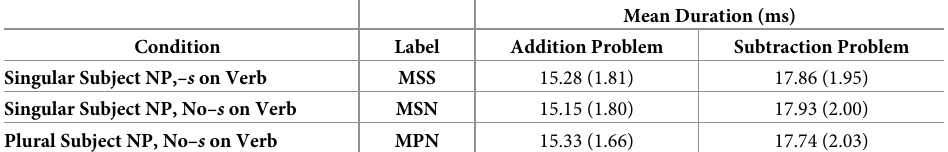
Table 11. Mean durations of the auditory stimuli for the mathematical reasoning experiment (seconds) with their SDs (in parentheses).